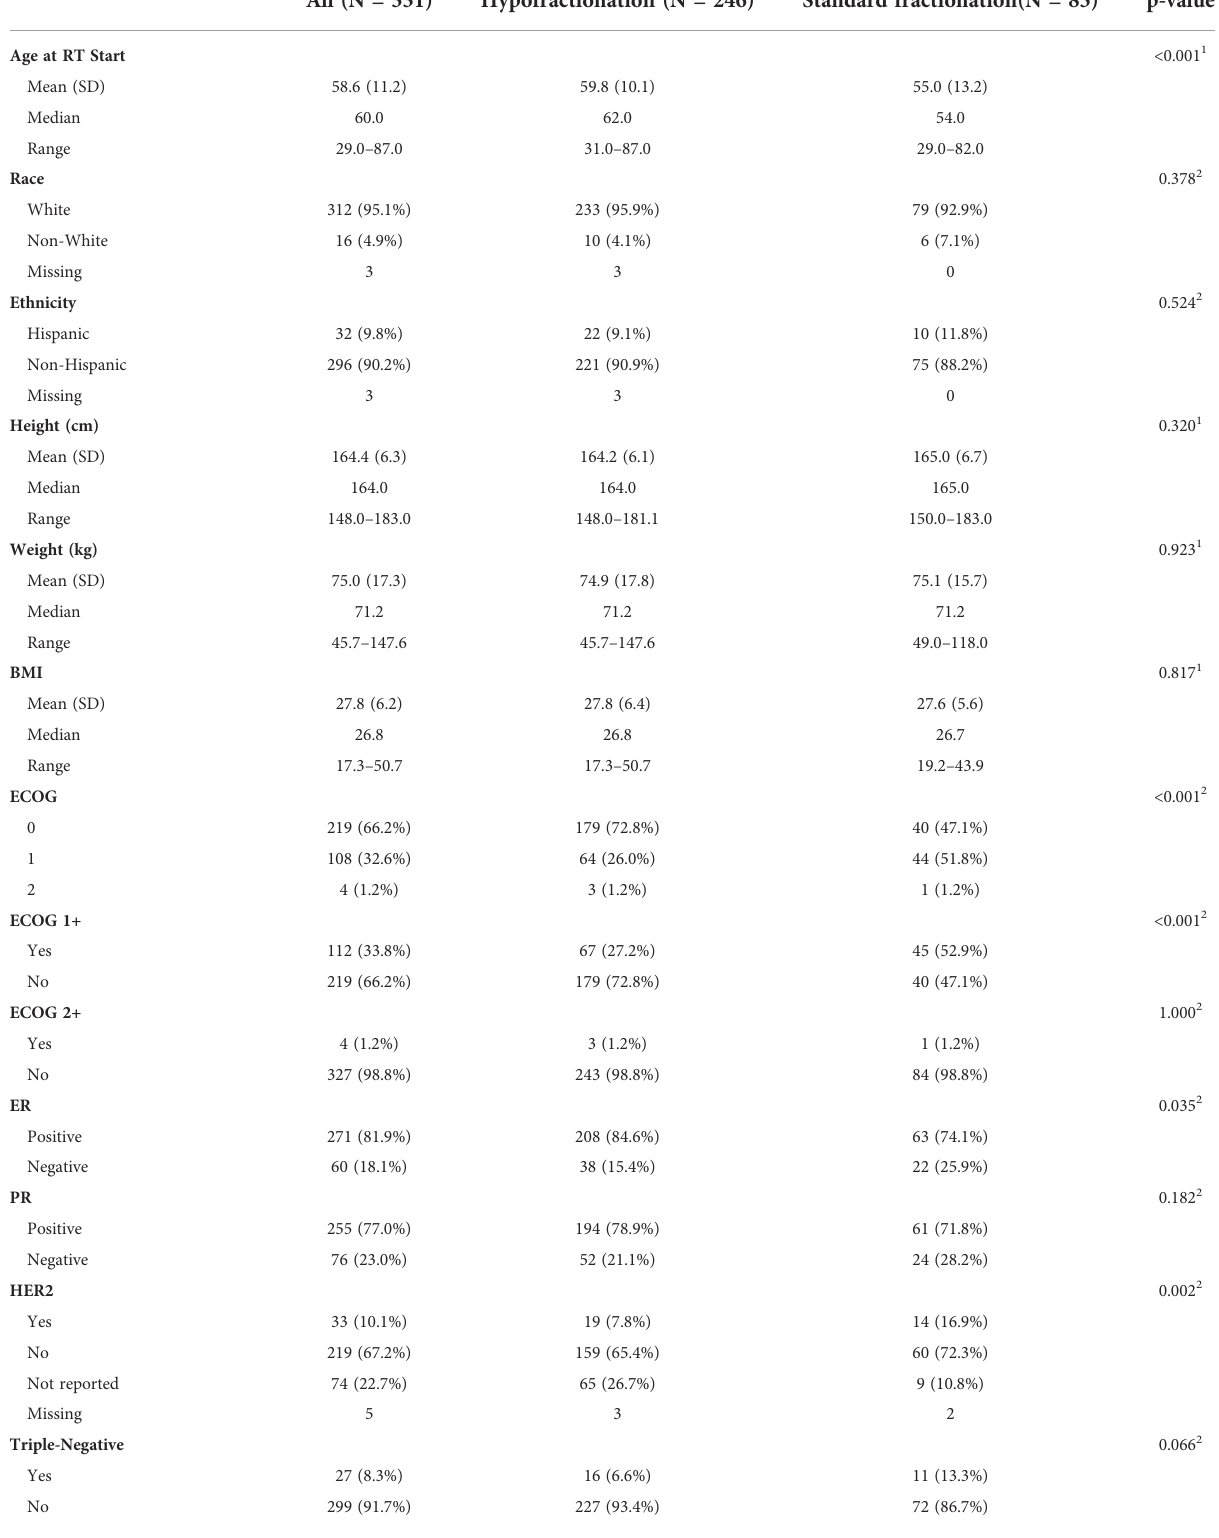
TABLE 1 Patient and treatment characteristics by